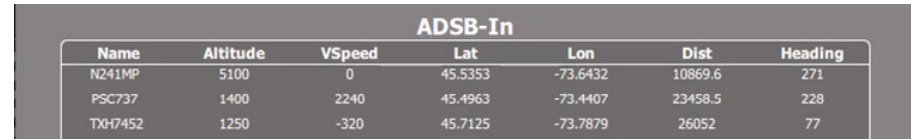
Figure 6. UGC Application ADS-B In’s output.